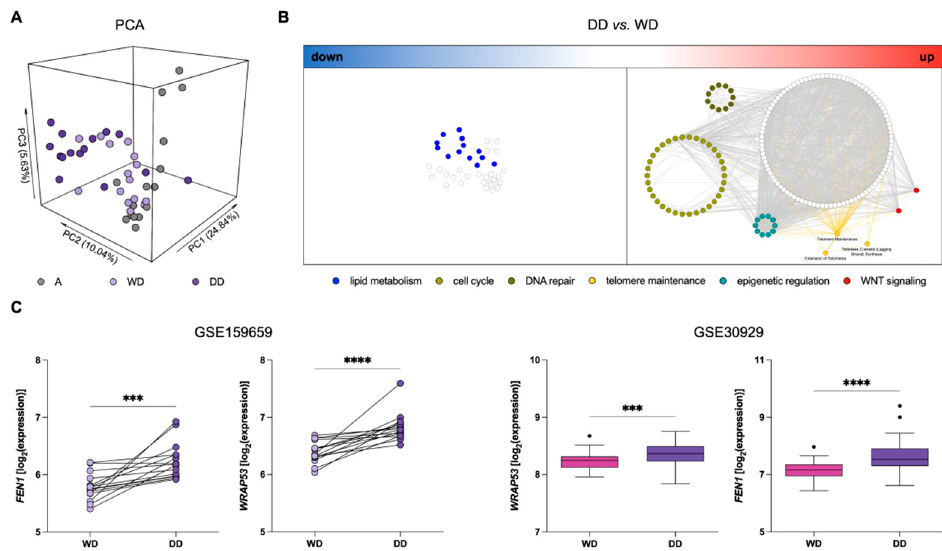
Figure 1 . Gene expression profiles in DDLPS clinical samples. ( A ) Principal component analysis (PCA) showing segregation among different types of samples: Normal adipose tissue (A; grey), well-differentiated (WD; light purple) and dedifferentiated (DD; dark purple) components of DDLPS. ( B ) Network of over-represented pathways in DD vs. WD components of DDLPS. A big cluster represented by “lipid metabolism” (blue nodes) is among the down-regulated pathways ( left ), whereas “cell-cycle” (light green nodes), “DNA repair” (dark green nodes), “epigenetic regulation” (aquamarine nodes), “WNT signaling” (red nodes), and “telomere maintenance” (yellow nodes and edges) are highlighted among the significantly up-regulated pathways ( right ). ( C ) Dotplot ( left ) and Tukey’s boxplots ( right ) of WRAP53 and FEN1 expression levels in the different tissue components: Wilcoxon test for GSE159659 paired samples ( left ) and Mann–Whitney test for GSE30929 ( right ) samples. *** p < 0.001, **** p <